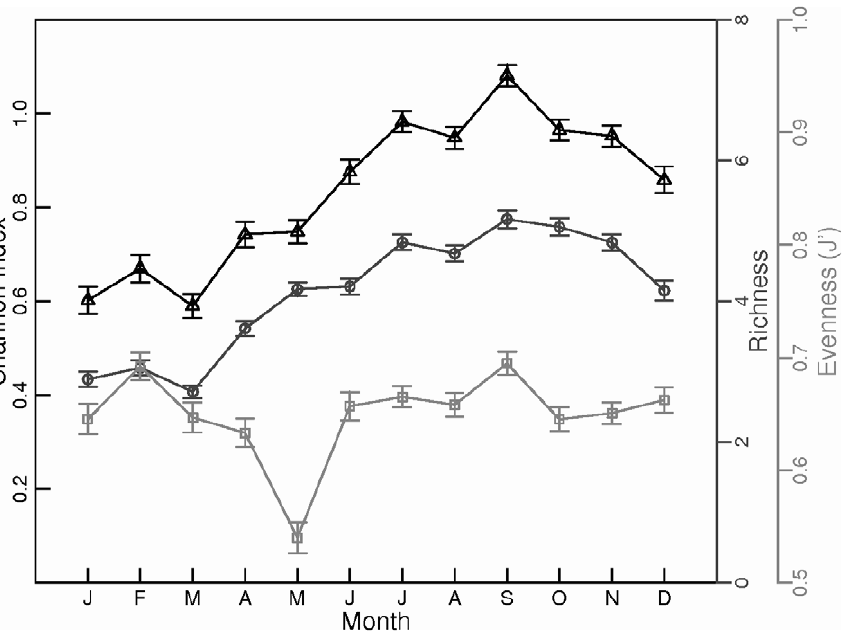
Figure 6. Seasonal variation in copepod species richness, evenness, and diversity in the Gulf of Maine. Richness (circles), evenness (squares), and diversity (triangles) were based on standardized Continuous Plankton Recorder samples. Bars indicate standard error. Sample size ranges from 289 to 422.